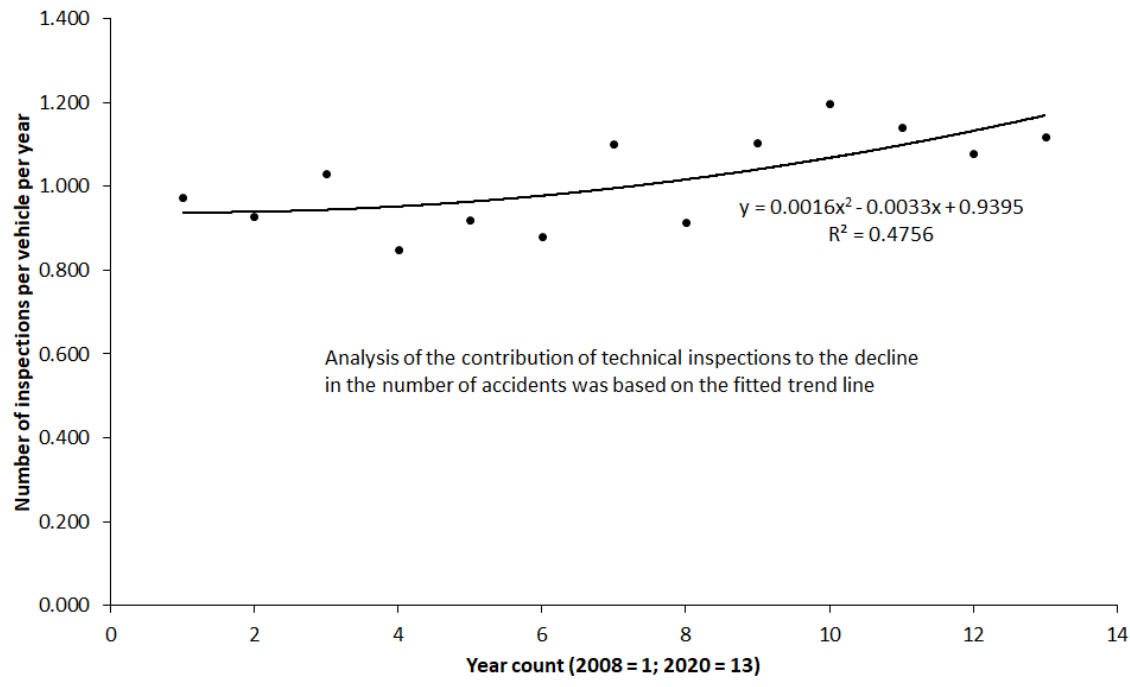
Figure 3 Number of technical inspections per heavy goods vehicle per